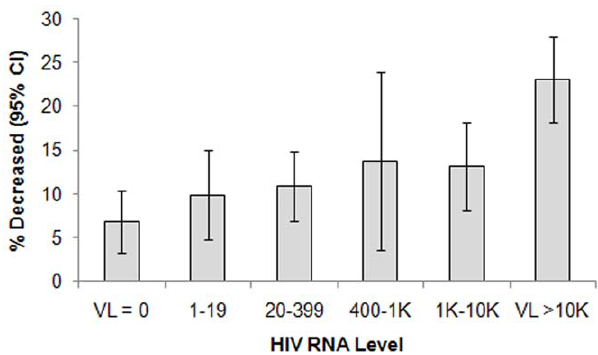
Figure 2. Prevalence of five-year all-cause mortality by HIV RNA level at baseline. Association of baseline HIVRNA (per 10-fold increase) with mortality: Demographic-adjusted: OR=1.39 (95%CI: 1.26 to 1.55), p , .0001 Fully-adjusted: OR=0.99 (95%CI: 0.87 to 1.13), p=0.90 Fully adjusted model includes demographics, traditional CVD risk factors (smoking, diabetes, blood pressure, total and HDL cholesterol), CD4 + cell count, CRP, and fibrinogen.